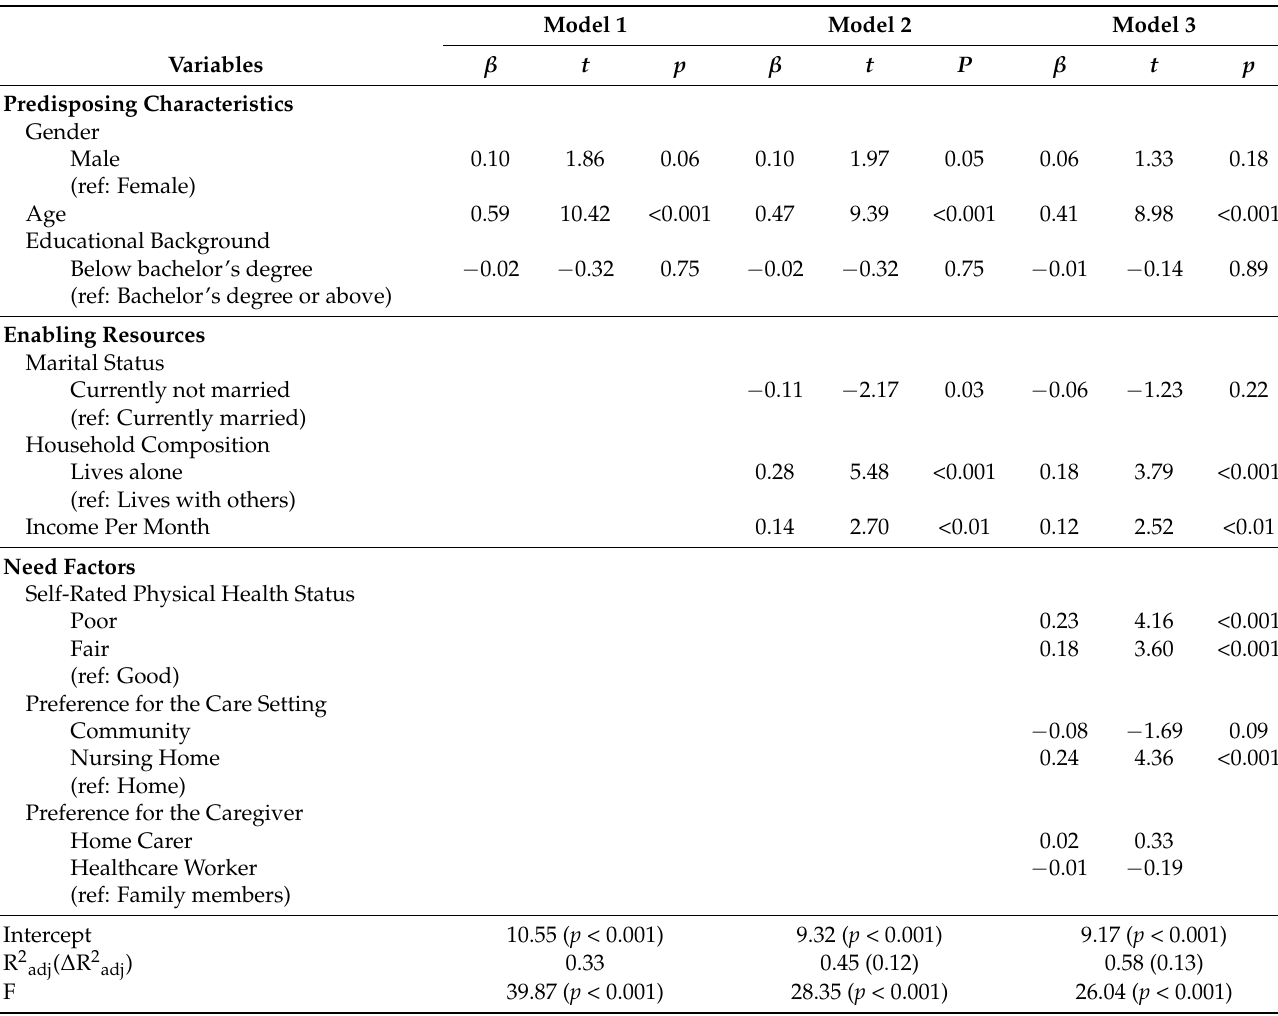
Table 5. Hierarchical Regression Analysis of Factors Influencing the Intended Use of Rehabilitation